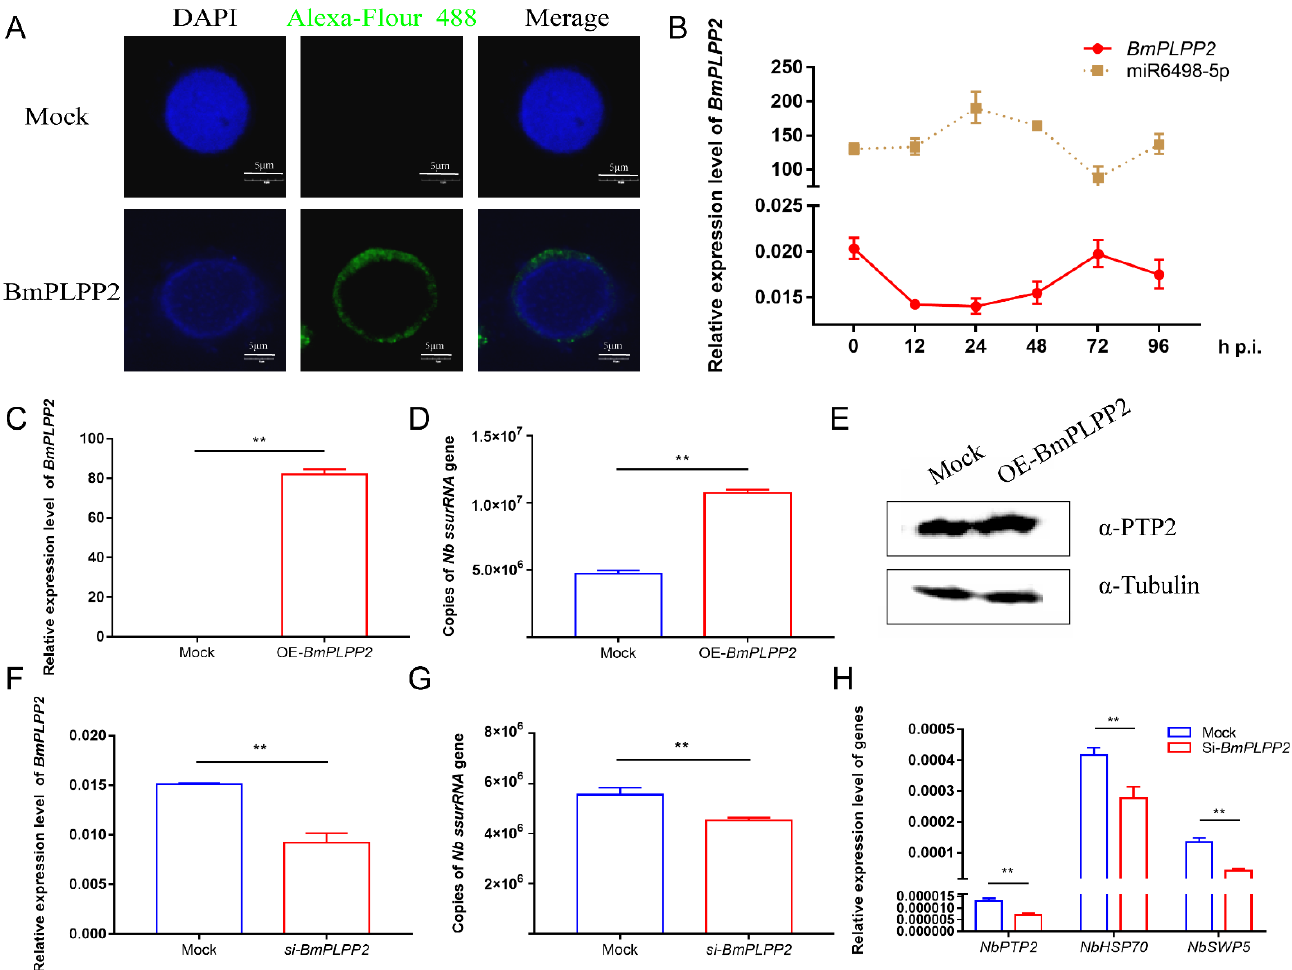
Figure 6. BmPLPP2 promotes the proliferation of N. bombycis ( A ) Expression alteration of BmPLPP2 after the infection of N. bombycis at different time points. ( B ) Immunofluorescence analysis of the location of BmPLPP2 . DAPI staining represents the nuclei, and green fluorescence represents the location of BmPLPP2. ( C ) qPCR analyzes the expression of BmPLPP2 in BmE cells by transfected with pIZ- BmPLPP2 . ( D ) Copy analysis of the N. bombycis ssurRNA gene in BmE cells transfected with pIZ- BmPLPP2 . ( E ) Western blotting analysis of the expression of N. bombycis α-PTP2 in BmPLPP2 overexpressing cells. ( F ) Expression analysis of BmPLPP2 in BmE cells transfected with siRNA. ( G ) Copy analysis of the N. bombycis ssurRNA gene in BmE cells by transfection with siRNA of BmPLPP2 . ( H ) Gene expression analyses of N. bombycisPTP2 , HSP70 and SWP5 in BmE cells by transfection with siRNA of BmPLPP2 . All data represent the means of three replicates ± SD, **, p < 0.01.